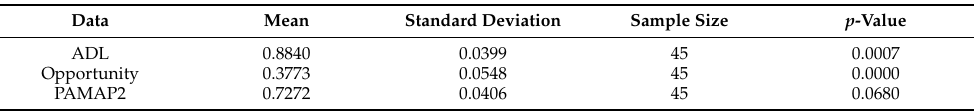
Table 8. Anderson–Darling normality test on sampling methods based on the 5 classifiers results × 9 sampling methods (5 × 9 = 45 sample size) on each dataset. The p -value is less than 0.05 ( α = 0.05) for ADL and Opportunity which suggests that ADL and Opportunity are not normally distributed compared to PAMPA2.